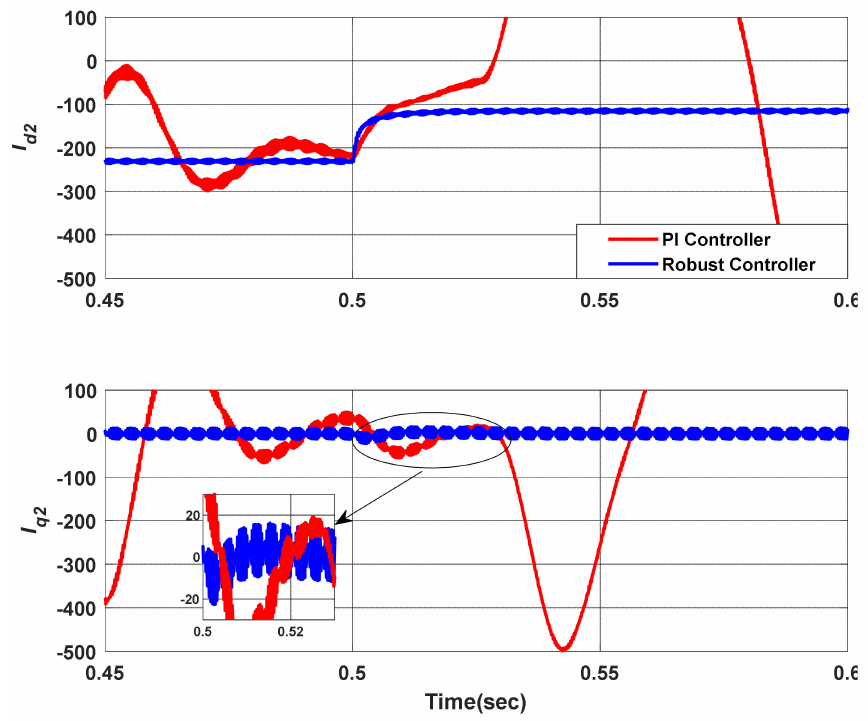
Figure 16. I d2 and I q2 for the off-nominal case for a 50% step change in active